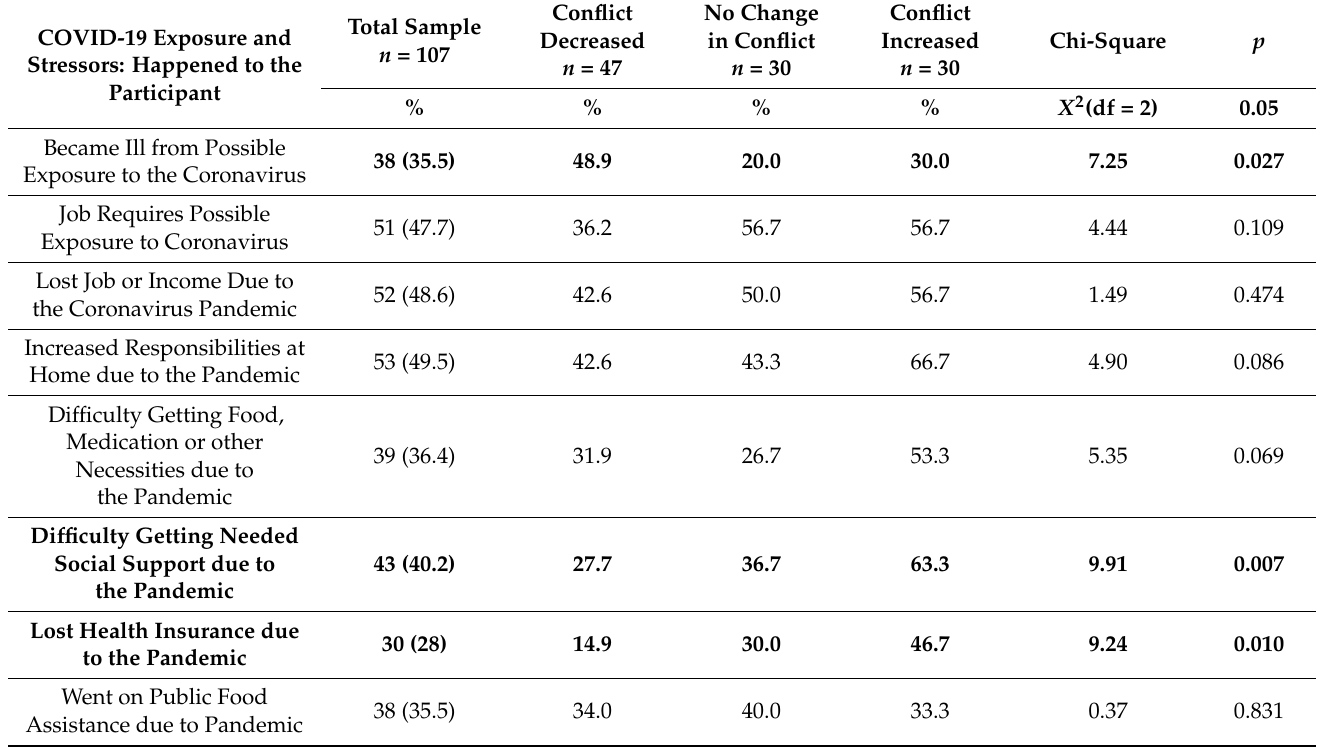
Table 2. Chi-square analyses of the three couple–conflict groups and the Coronavirus Stressor